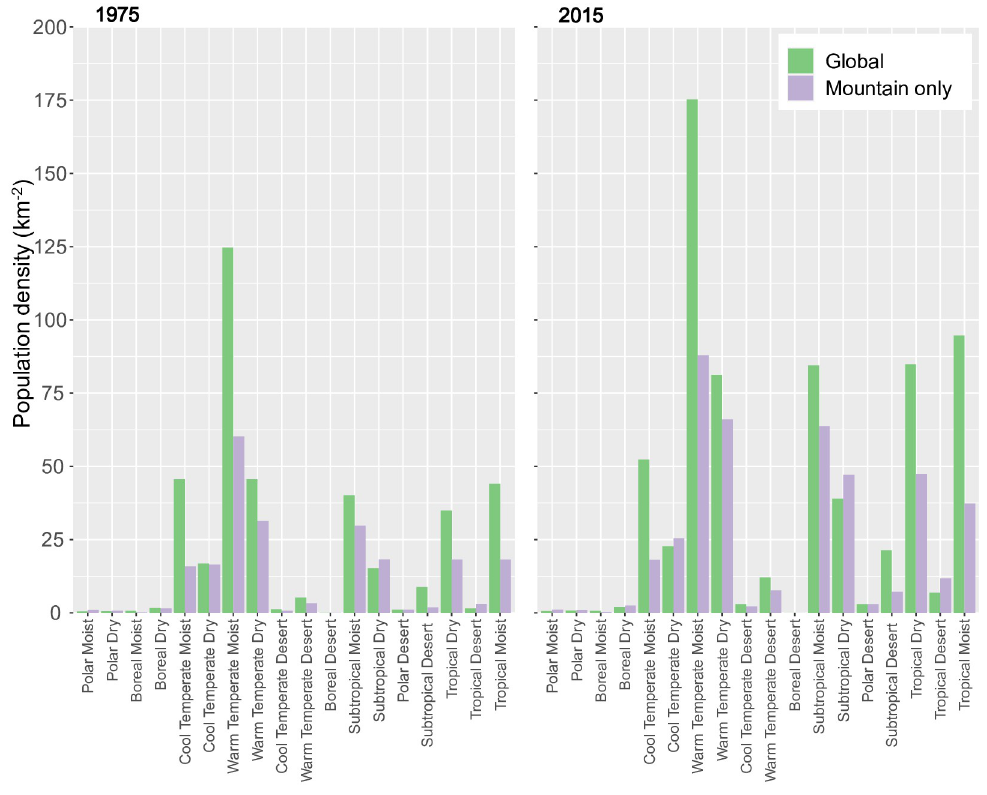
Fig 6. Mean population density for entire World Climate Regions (WCRs) (“Global”) and the mountainous parts thereof (“Mountain only”) for 1975 and 2015 according to GHS-POP and the K1 mountain delineation. Plots for the intermediate years (1990 and 2000) are included in an animated sequence in the online S1